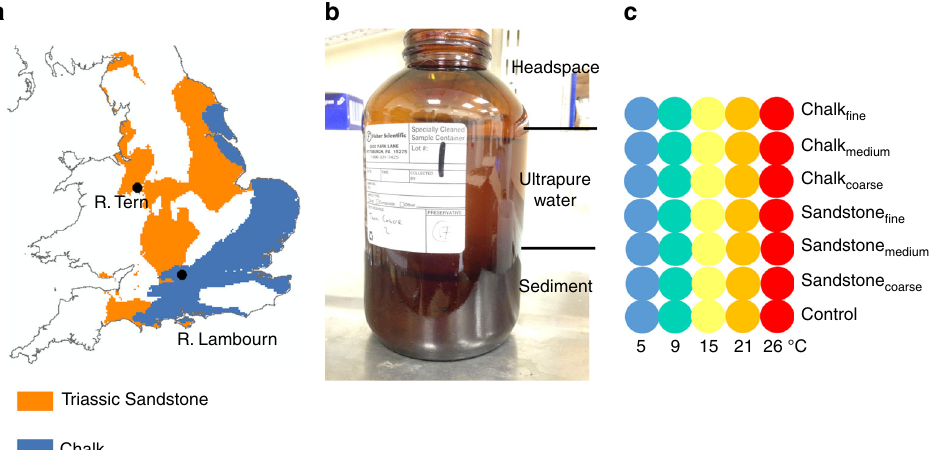
Fig. 1 The location of the study rivers and experimental design. a Map of England and Wales, UK, showing the spatial distribution of Triassic Sandstone and Chalk aquifers, and the two study streams (River Tern and River Lambourn) [Contains British Geological Survey materials Copyright NERC [2016] and gadm.org]. b Incubation bottle used for the experiment, including a depiction of the distribution of sediment, water and headspace. c Experimental setup with each dot representing a triplicate of